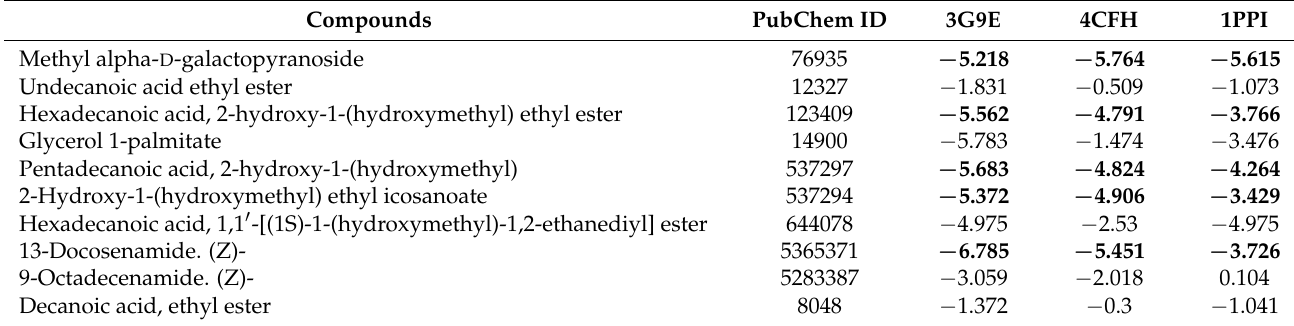
Table 7. Docking score for major biometabolites of ME X LS.